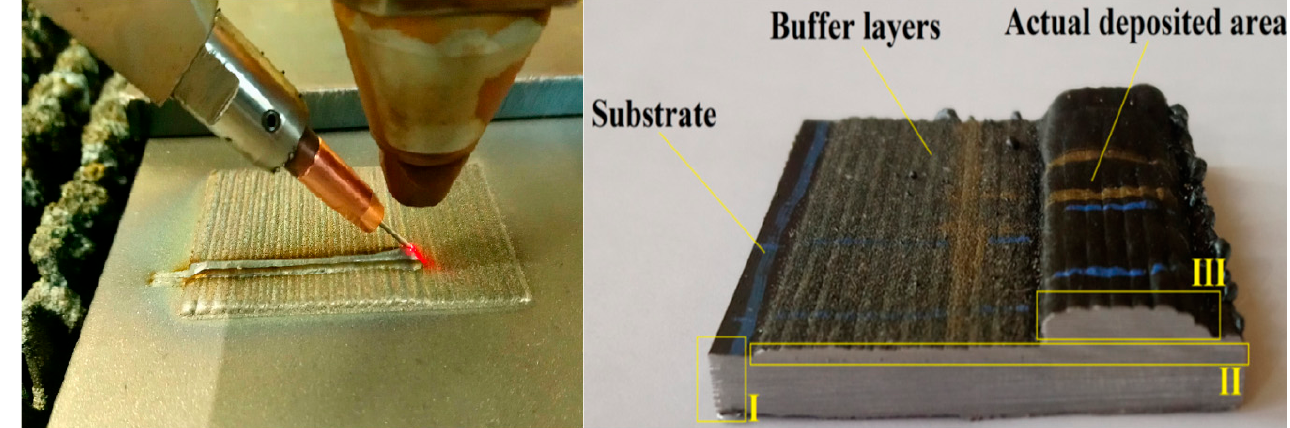
Figure 1. Deposition and the developed specimen using the semi-hybrid method.